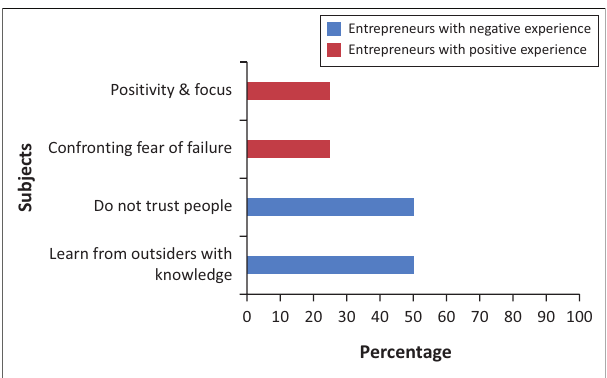
FIGURE 4: Relative indication of personal learning content dimensions identified by